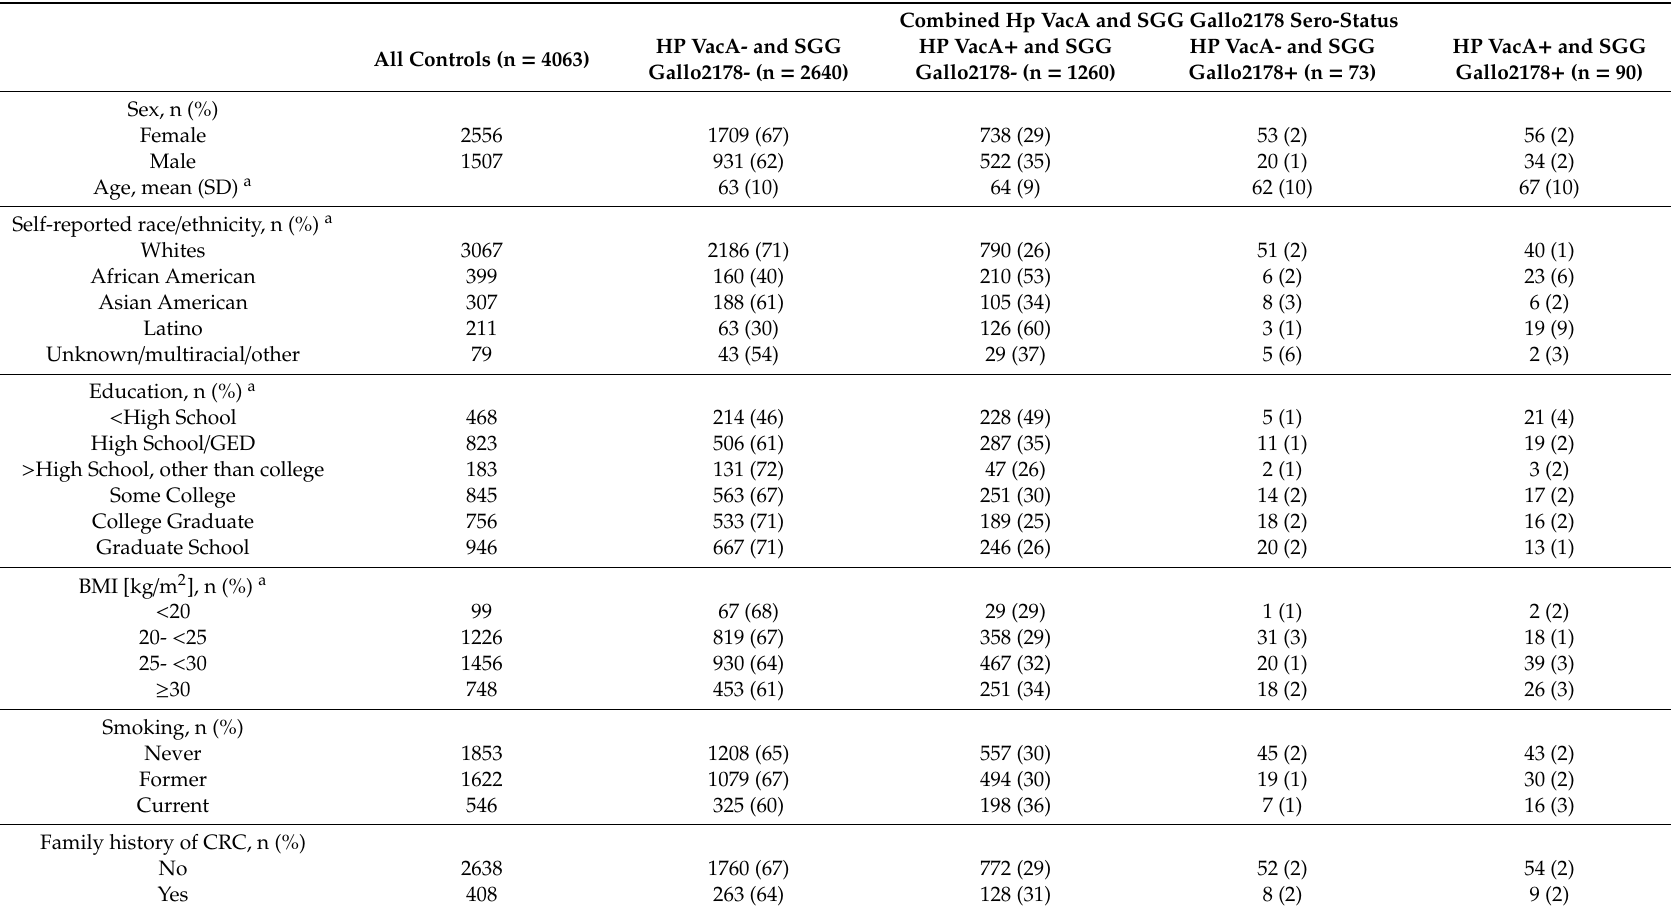
Table 1. Baseline factors among controls, overall and by combined H. pylori VacA (HP VacA) and Streptococcus gallolyticus subsp. gallolyticus ( S. gallolyticus ) (SGG) Gallo2178